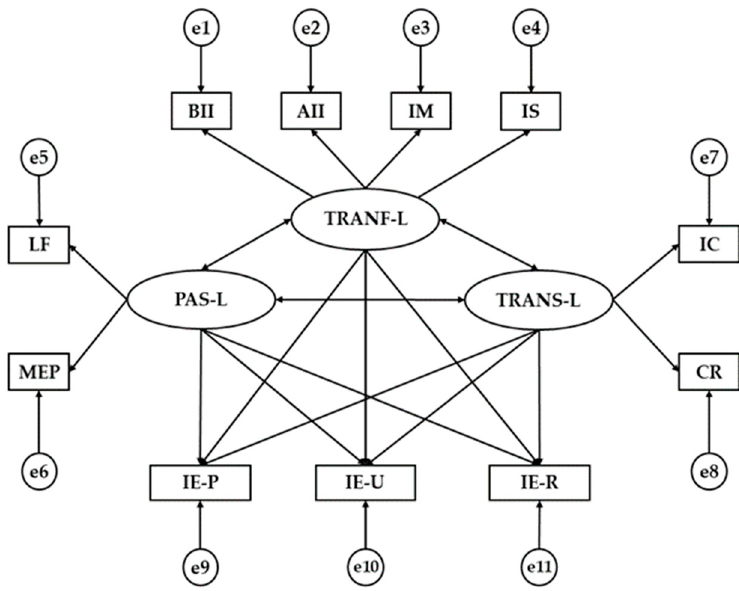
Figure 1. Theoretical model. Note1: TRANF-L, Transformational Leadership; TRANS-L, Transactional Leadership; PAS-L, Passive Leadership; BII, Behavioral Idealized Influence; AII, Attributed Idealized Influence; IM, Inspired Motivation; IS, Intellectual Stimulation; IC, Individualized Consideration; CR, Contingent Reward; MEP, Management-by-Exception Passive; LF, Laissez-Faire; IE-P, Emotional Intelligence Perception; IE-U, Emotional Intelligence Understanding; IE-R, Emotional Intelligence Regulation.